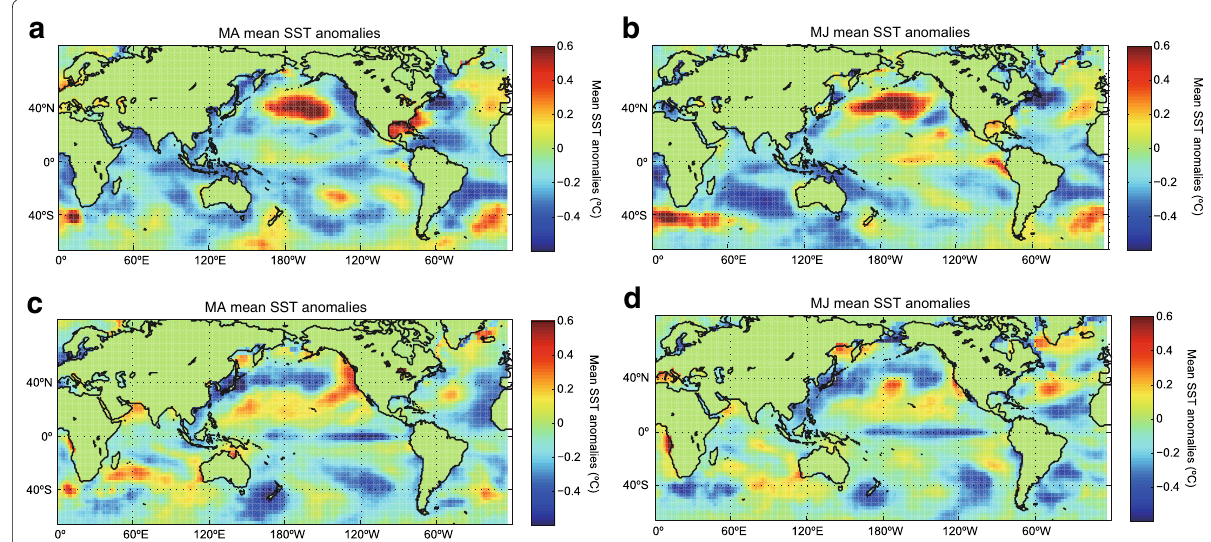
Fig. 6 a MA and b MJ mean SST anomalies for six negative tree-ring cellulose events (A.D. 1938, 1947, 1954, 1956, 1966 and 1981). c + + d MJ mean SST anomalies for six positive tree-ring cellulose events (A.D. 1933, 1940, 1942, 1963, 1975, and 1987). Datasets were from ERSST (Smith + et al. 2008), and these anomalies were calculated from the difference between SST in these years and the SST average during A.D.